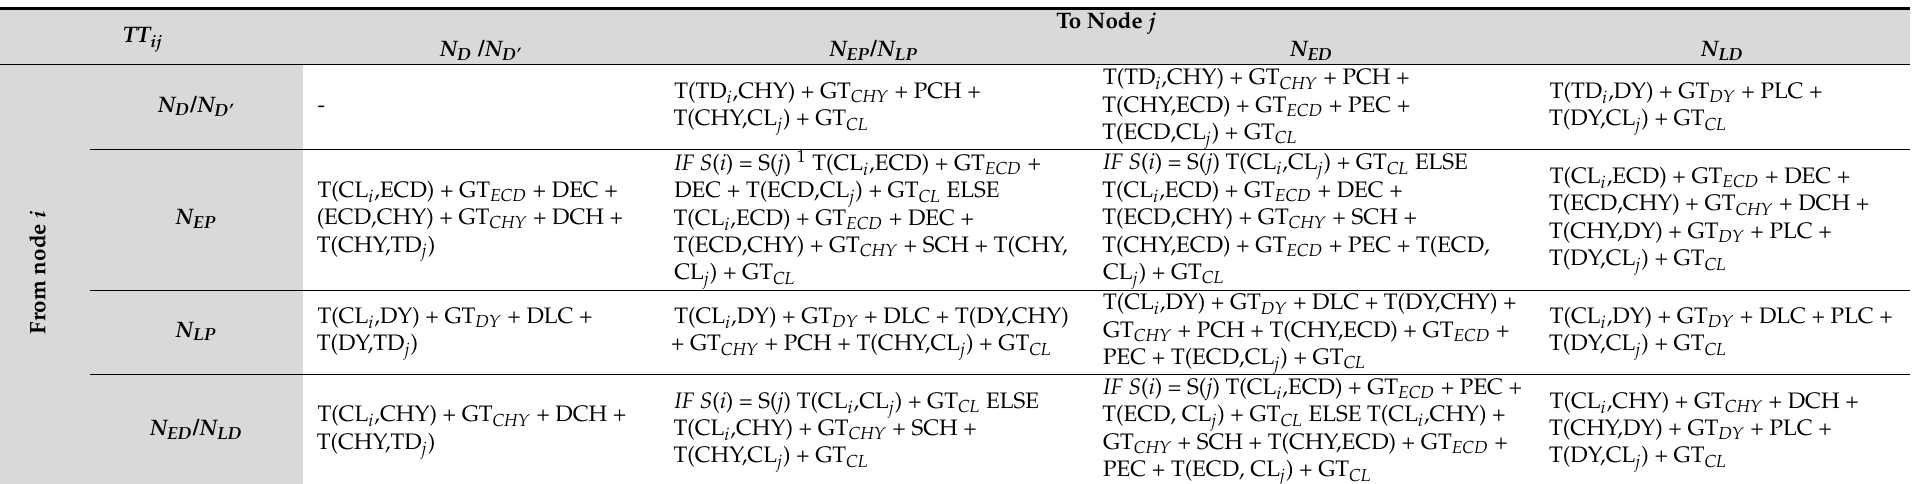
Table 3. Transfer Time on Arc ( i , j ) for Scenario